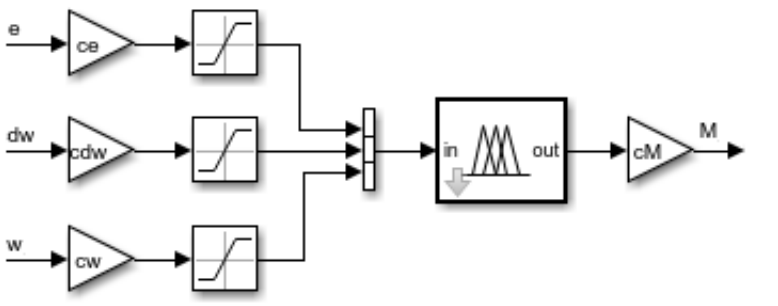
Figure 11. The structure of the fuzzy control system.